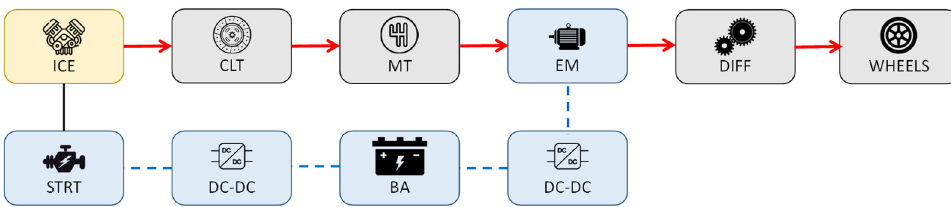
Figure 6. Energy fluxes in pure thermal mode.